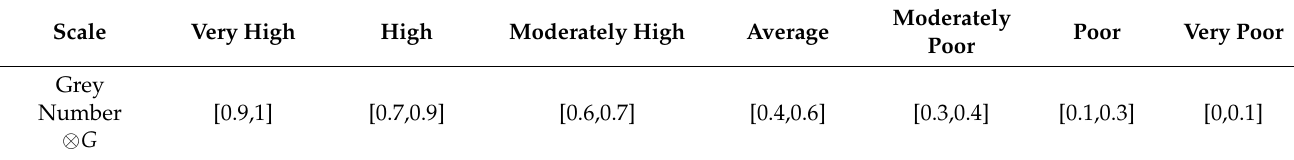
Table 2. RI for each value of n